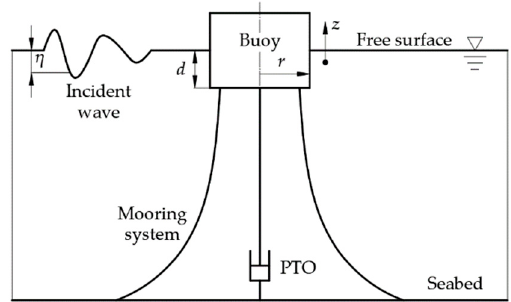
Figure 1. A schematic diagram of the heaving point absorber.